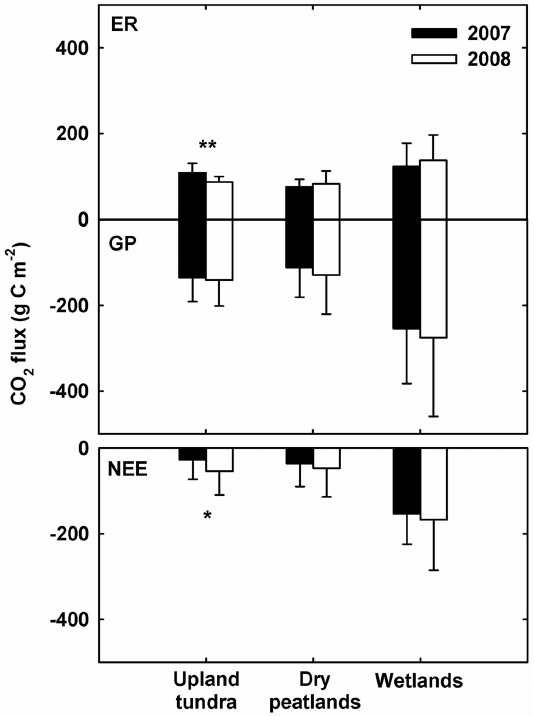
Fig. 8. Cumulative CO 2 fluxes during summer period (July–August) in the three main land cover types in 2007 and 2008 (mean ± SD; n = 3). Significant differences between years are shown; ** = p < 0 . 01; * = p < 0 .